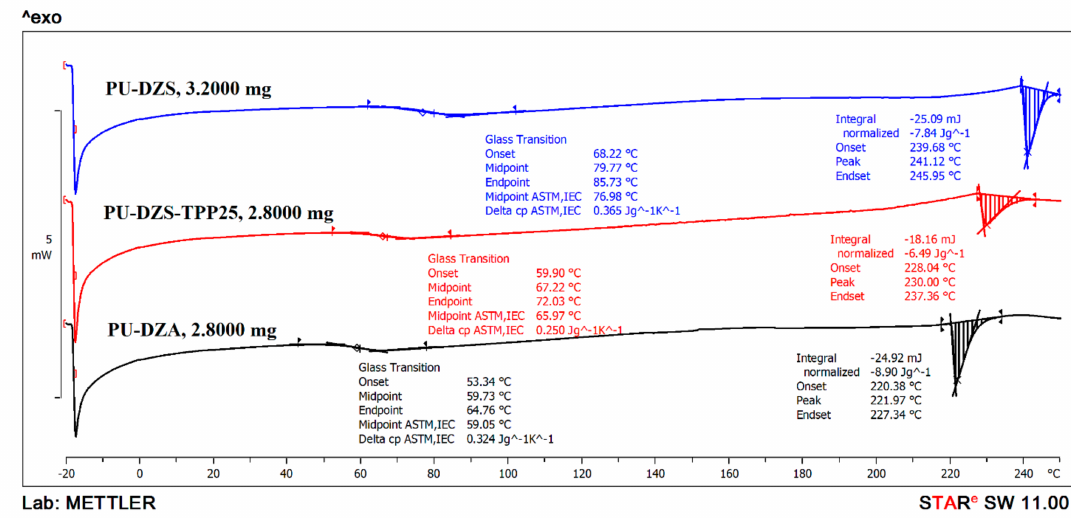
Figure 7. DSC curves of the PUF samples prepared from MDI and diols: DZS, DZS-TPP 25 and DZA. The second heating from − 50 to 200 ◦ C at a rate of 10 ◦